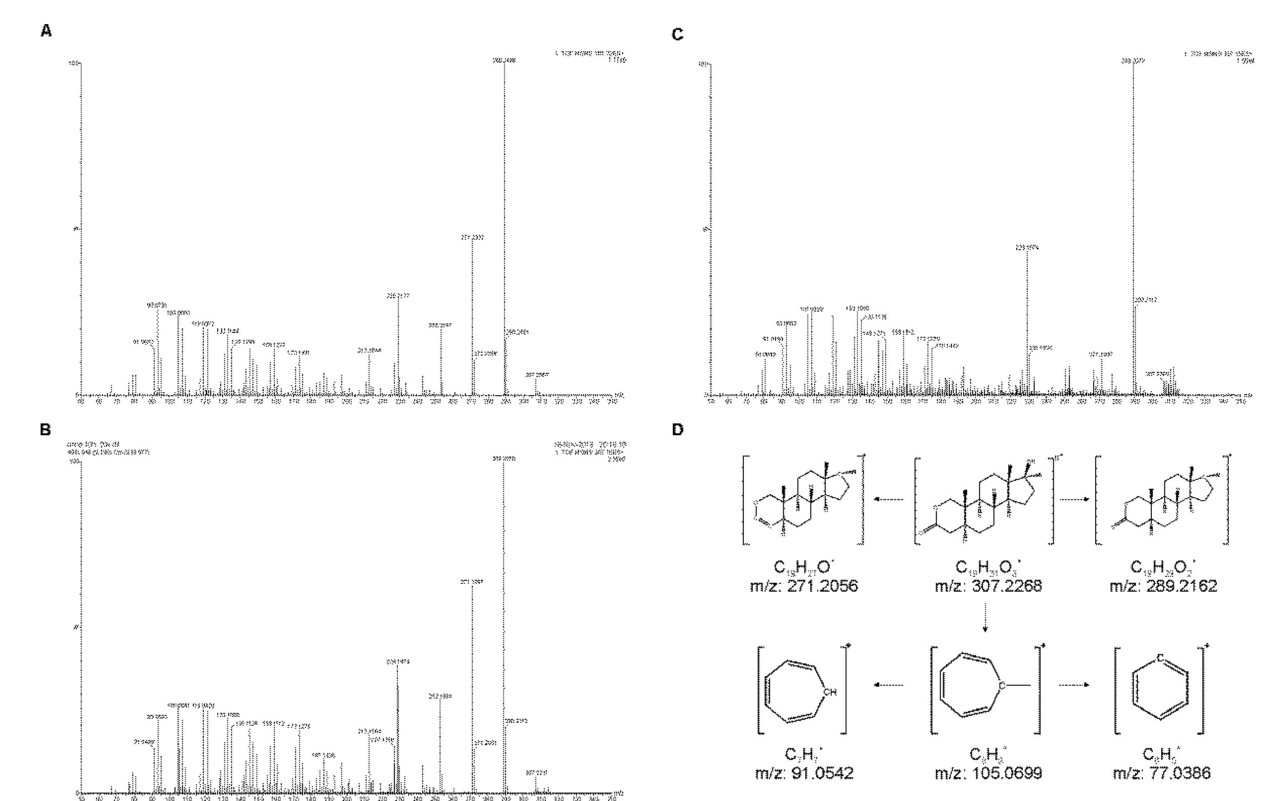
Figure 2. LC-QTOF identification of oxandrolone (OXA) and its metabolite. The MS2 spectrum of ( A ) standard OXA, ( B ) OXA in a urine sample, ( C ) OXA metabolite 17-epi-oxandrolone in a urine sample, and ( D ) the structures of molecular and daughters ions used for identification and quantification.